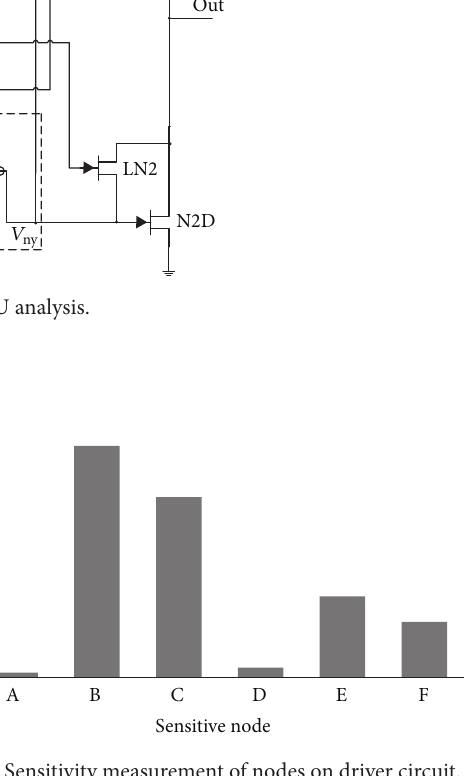
Figure 3: Sensitivity measurement of nodes on driver